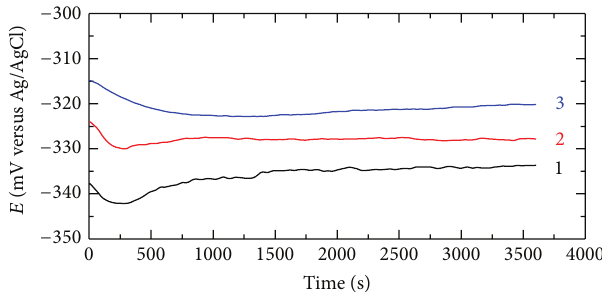
Figure 1: Change of the open-circuit potential versus time for the HSLA steel in 2.0 M H 2 SO 4 solutions in the absence (1) and presence (2) of 1.0 mM ATA and (3) 5.0 mM ATA,